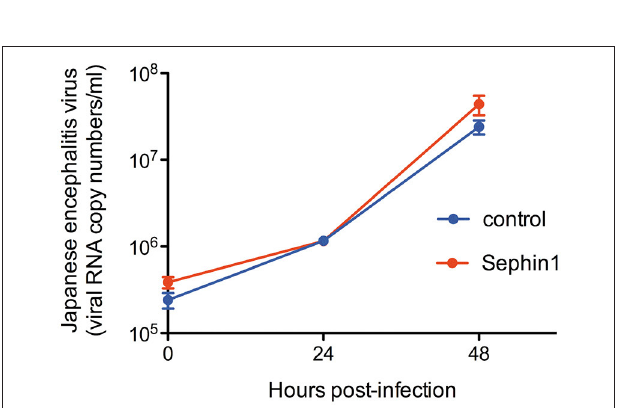
FIGURE 4 | Evaluation of the antiviral properties of Sephin1 against enterovirus ED68. (A) RD cells were infected with enterovirus ED68 and incubated at 33 ◦ C in the presence of 50 µ M Sephin1 or DMSO alone (control). Viral titers were determined from supernatants harvested at the indicated times post-infection. (B) Viability of RD cells incubated with increasing doses of Sephin1 or DMSO alone was determined after 24h of incubation using the cellular viability assay Vita-Blue. Data represent mean ± SEM from representative experiments, repeated at least three times. * p < 0.05 by one-way analysis of variance, followed by Bonferroni comparison test comparing the Sephin1-treated groups at the indicated concentrations to the vehicle-treated control group.